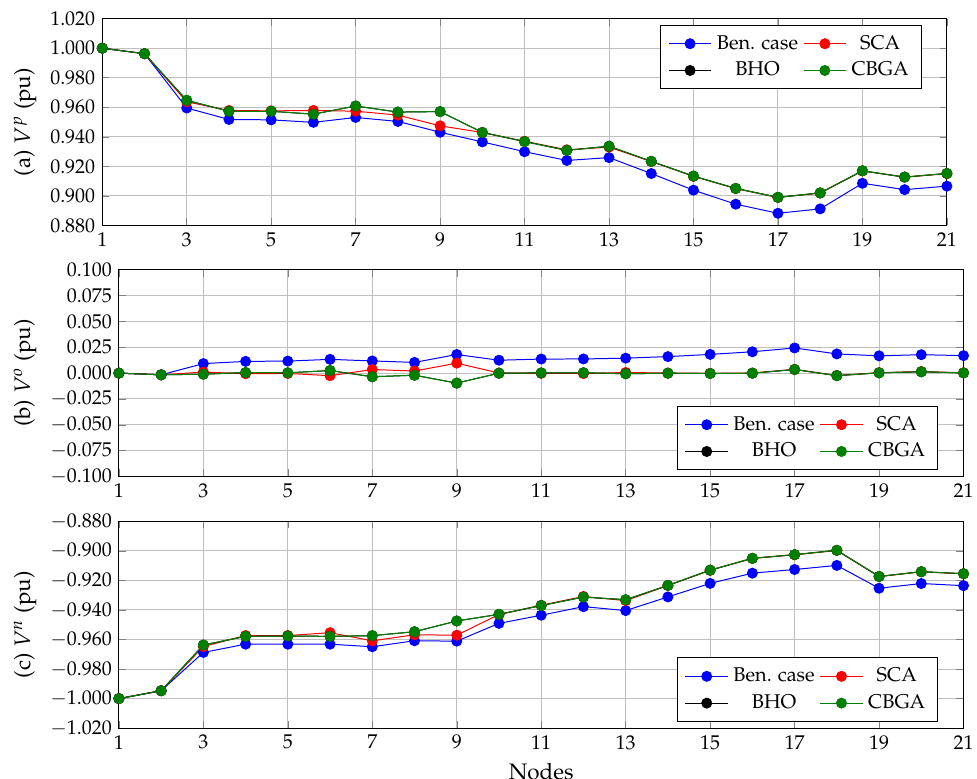
Figure 3. Behavior of the voltages for all poles in the 21-bus systems with each one of the metaheuristic optimizers: ( a ) voltage value at the positive pole, ( b ) voltage value at the neutral pole, and ( c ) voltage value at the negative